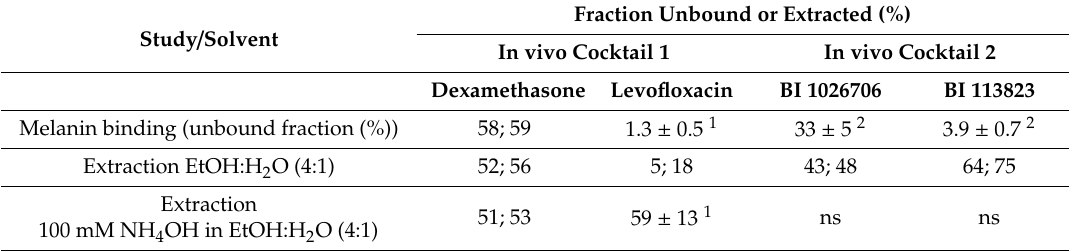
Table 1. In vitro melanin binding and extraction of the studied compounds from Sepia melanin (1 mg / mL melanin and 1 µ M compound concentration). Individual values presented if two replicates were studied, mean ± standard deviation presented if more than two